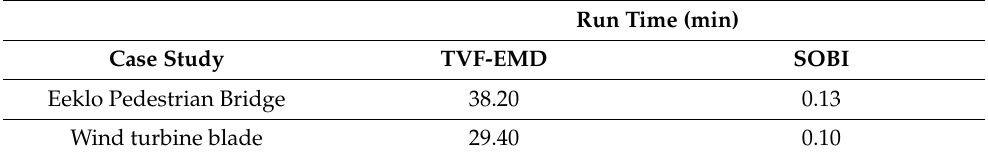
Table 8. The average run-time of the methods in both case studies.